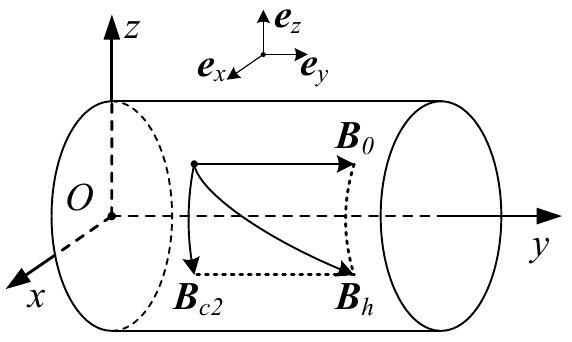
Figure 4. The magnetic induction vector distribution on the surface of the waveguide wire.